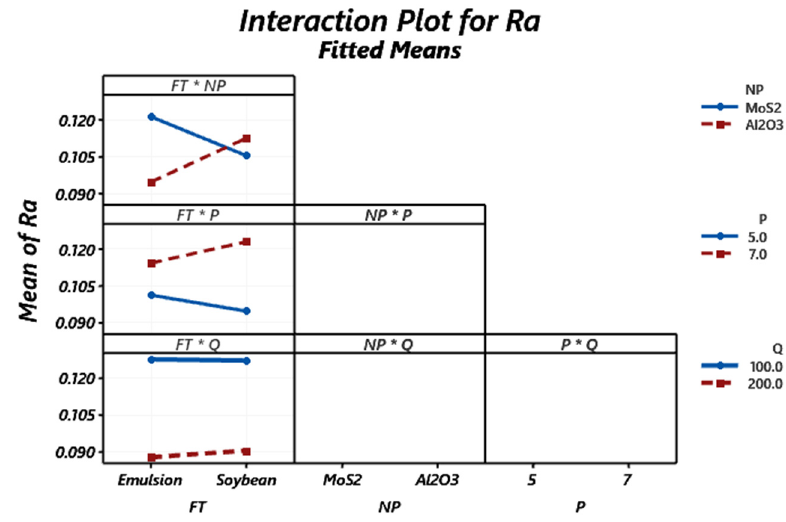
Figure 6. Interaction plot of input machining factors on surface roughness R a.